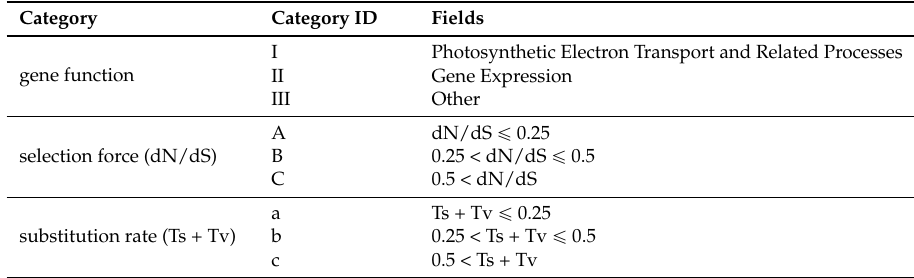
Table 4. The genes were sorted into categories by the gene functions, average dN/dS and Ts + Tv values among lineages. The phylogenetic analyses were performed according to these gene groups in order to determining whether the gene function, selection force and nucleotide substitution rate impact phylogenetic estimation